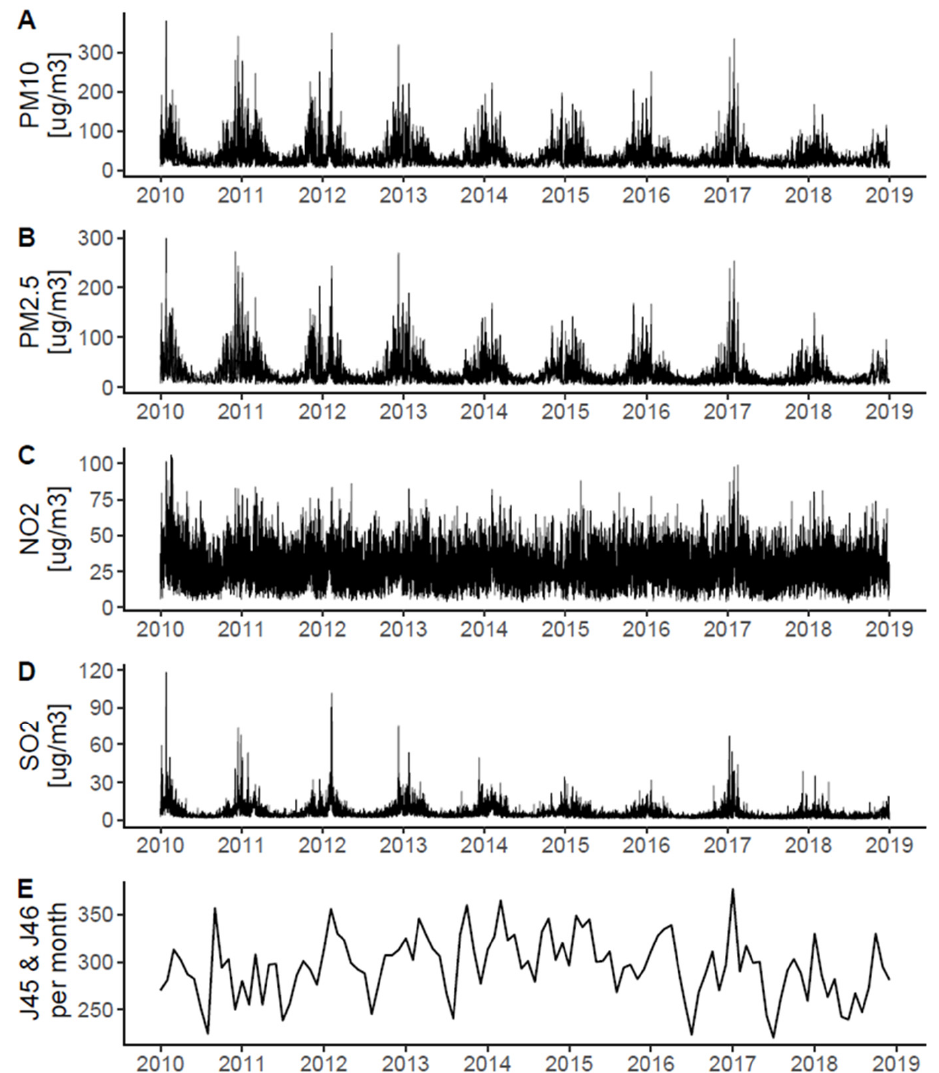
Figure 1. Daily concentrations of PM 10 ( A ), PM 2 . 5 ( B ), NO 2 ( C ), and SO 2 ( D ) in the study period. Monthly counts of hospitalizations due to the J45 or J46 ICD-10 codes ( E ) (“asthma”). Table 1. Average daily concentrations of air pollutants, average daily values of meteorological variables, and total counts of asthma admission by city.